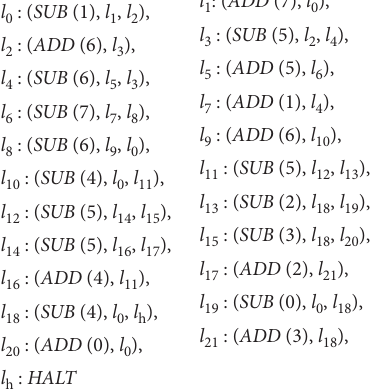
u : containing 8 registers